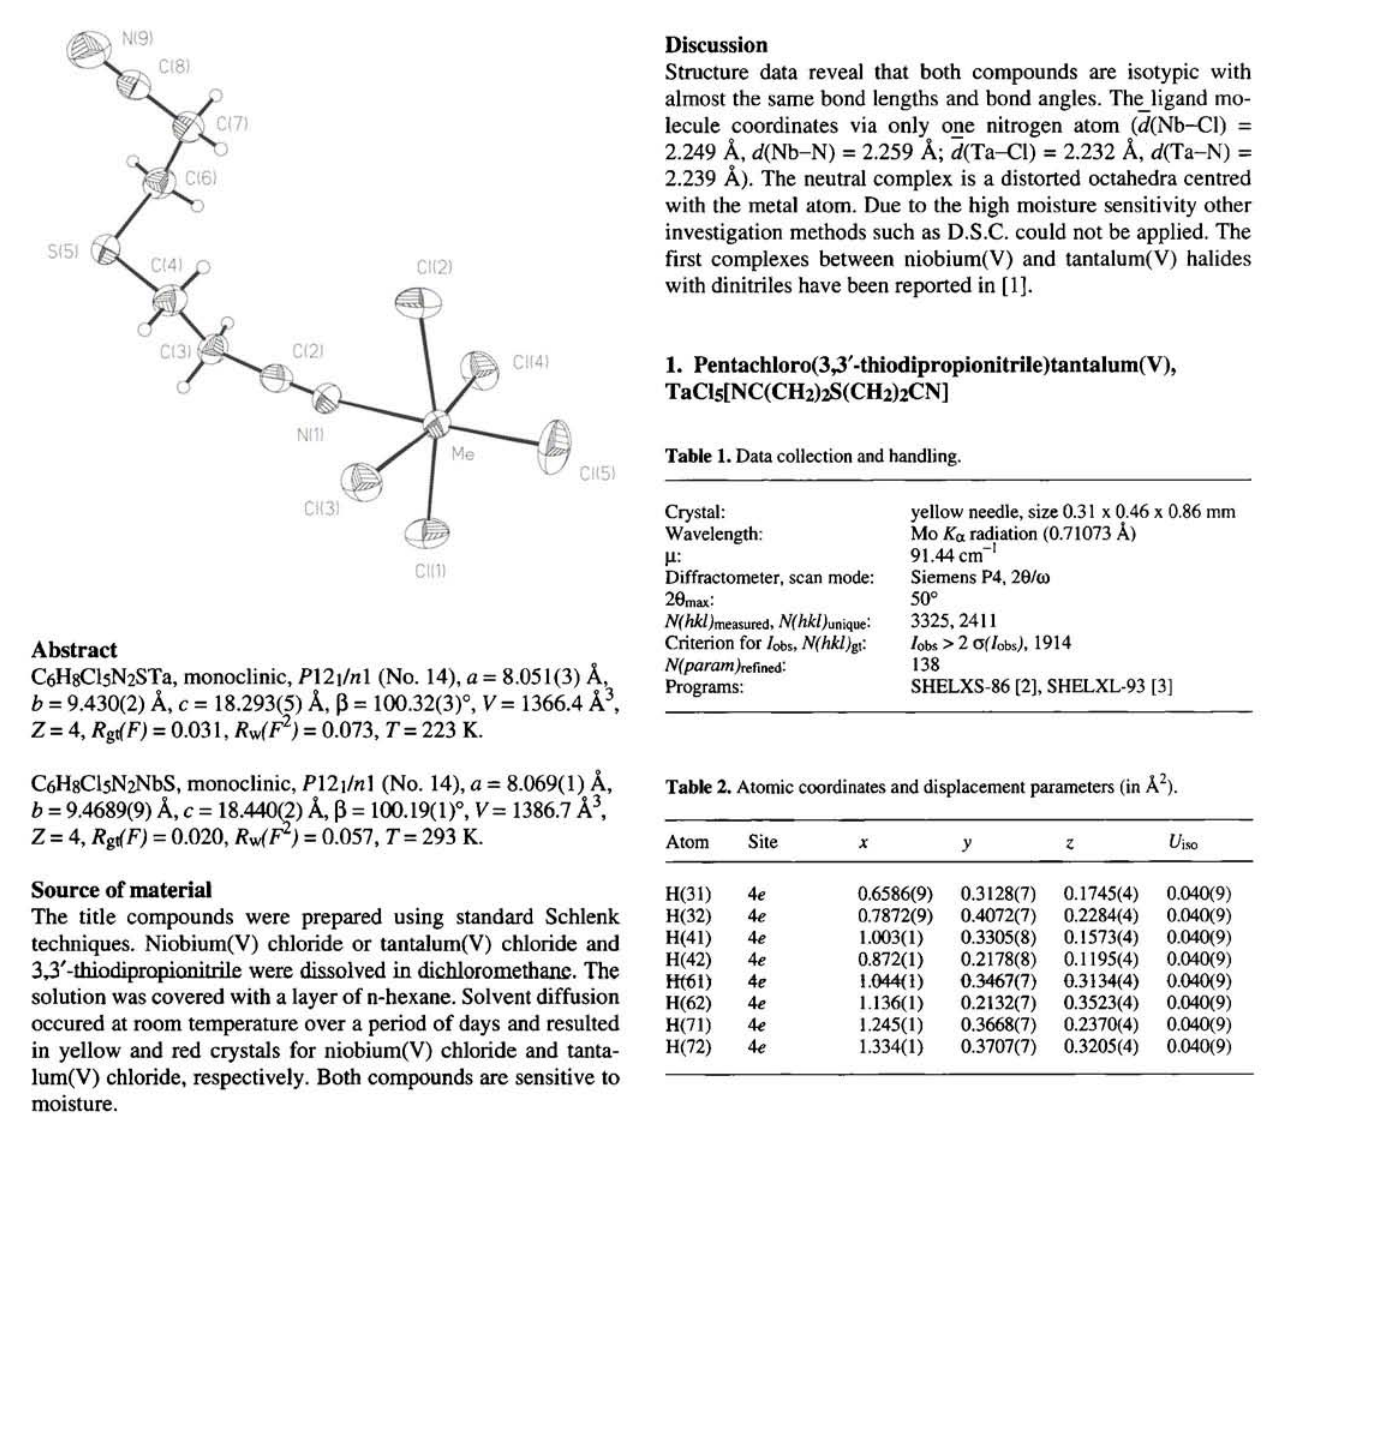
Table 1. Data collection and handling.